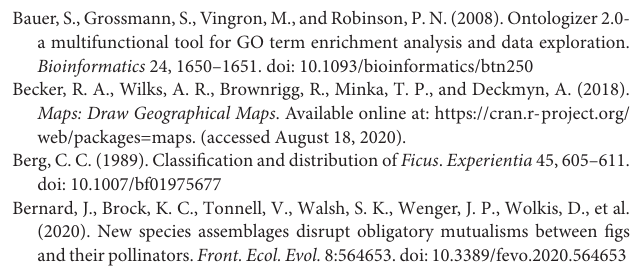
Supplementary Table 1 | List of sampling sites in the generalized dissimilarity modeling. Supplementary Table 2 | Statistics of sequencing. Supplementary Table 3 | Results of Shapiro-Wilk normality test. Supplementary Table 4 | Results of Wilcoxon rank sum test. Supplementary Table 5 | List of differentiated